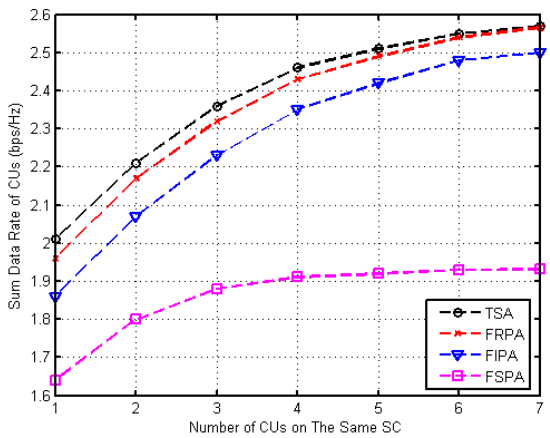
Figure 11. Plot of the sum data rate of CUs on the same SC with respect to the number of CUs. On each SC, the number of CUs changes from 1 to 7.